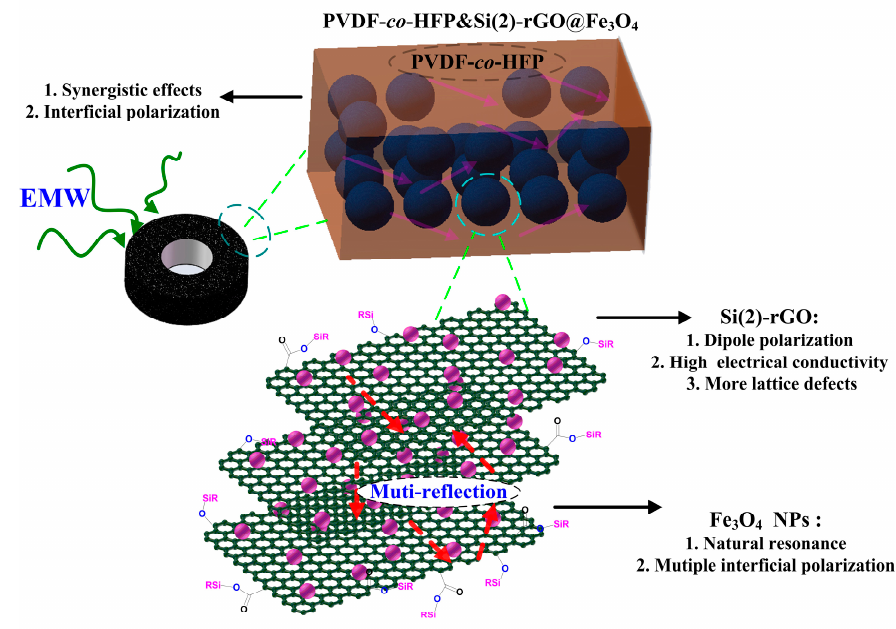
Scheme 2. Schematic illustration of the proposed EMA mechanism of S2